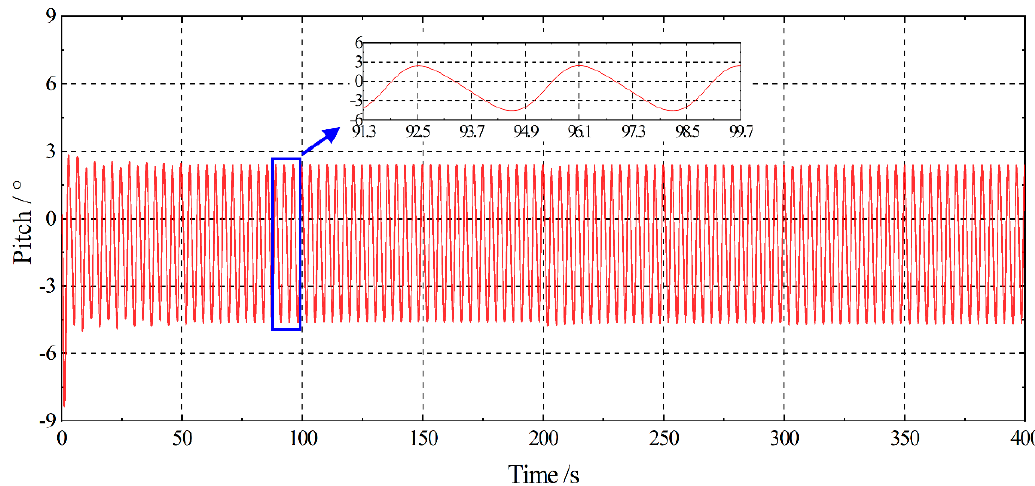
Figure 11. Time history of the pitching angle of the towing ship.